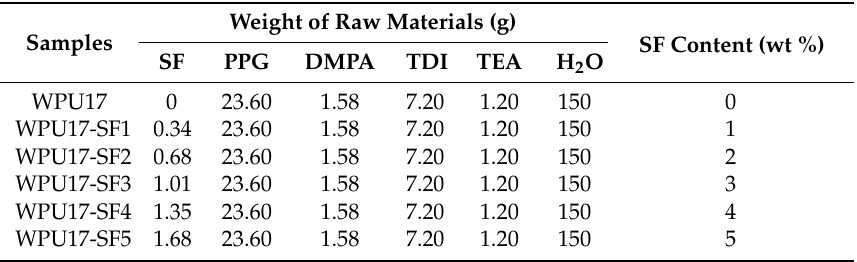
Formulation of the waterborne polyurethane (WPU17) and WPU17-silk fibroin (WPU17-SF)